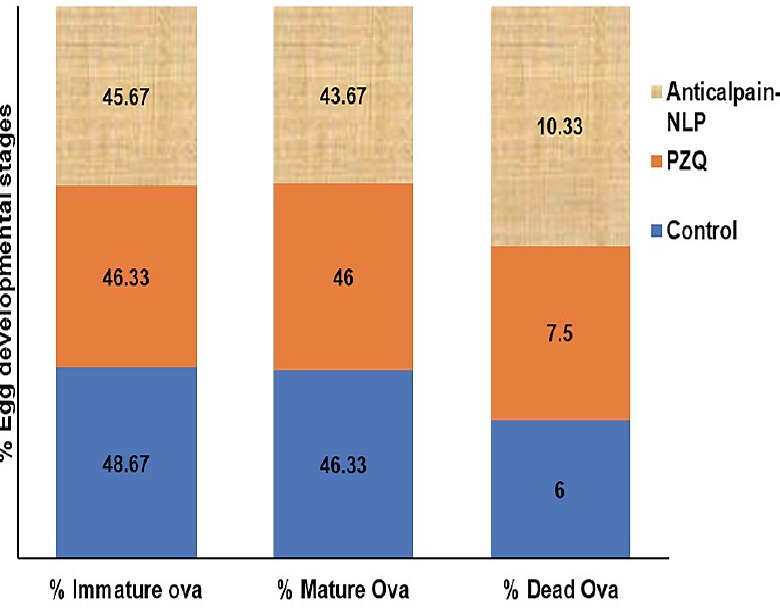
Figure 13. Effect of PZQ and anti-calpain-NLP (single dose 250 mg/kg two weeks post infection) on % egg developmental stages in S. mansoni -infected mice sacrificed six weeks post infection. Table 2. Effect of PZQ and anti-calpain-NLP (single dose 250 mg/kg two weeks post infection) on number of ova/gm tissues in S. mansoni -infected mice sacrificed six weeks post infection.